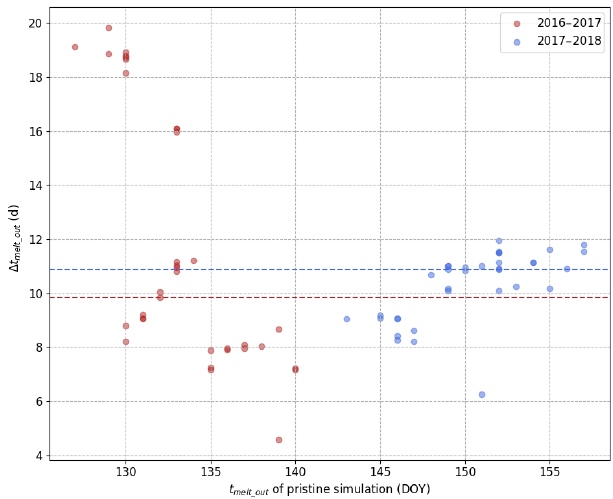
Figure 7. The (cid:49)t melt-out values as a function of the date of melt of the pristine simulation for each of the 35 members and each